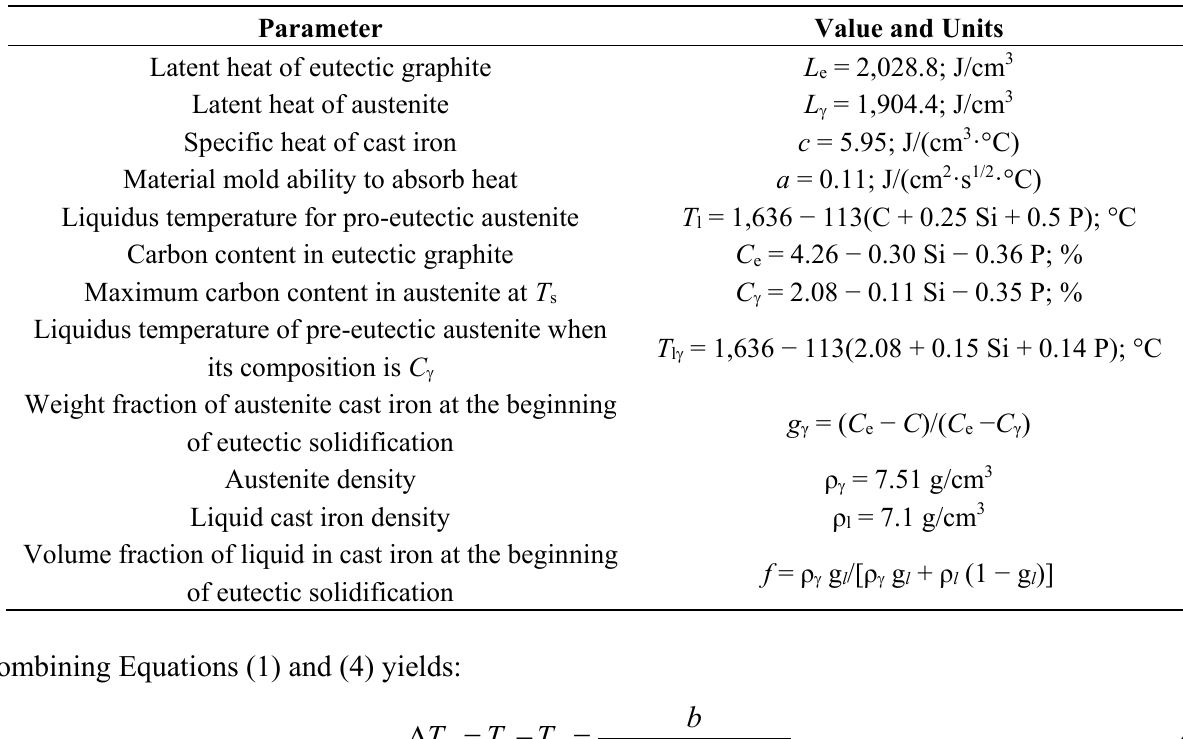
Table 1. Selected thermophysical data [14]. C, Si, P: % content of carbon, silicon and phosphorus in cast iron,